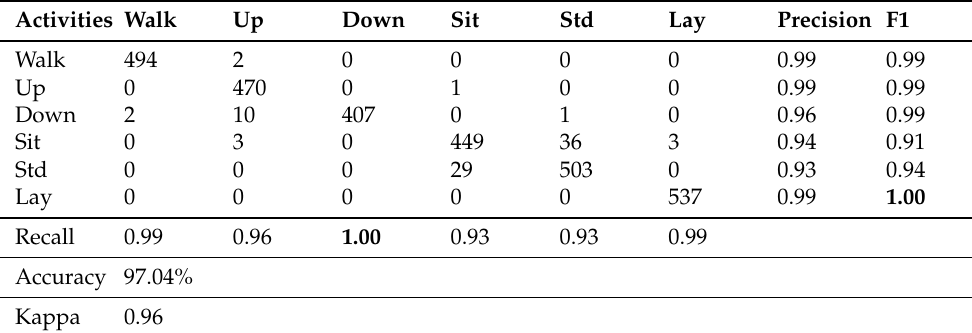
Table 6. Classification of the confusion matrix on the UCI-HAR.